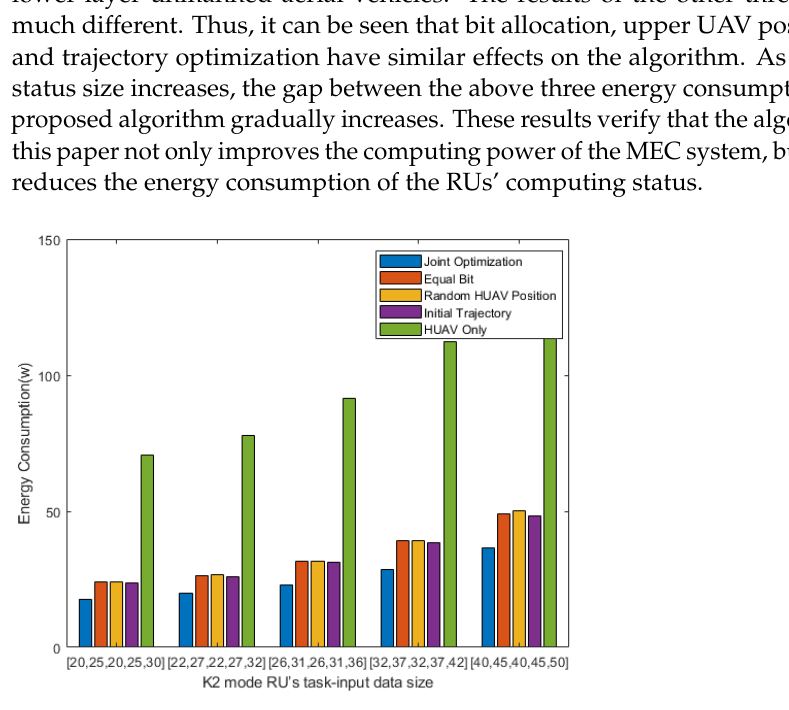
Figure 3. The relationship between the RU’s status size and each scheme’ s energy consumption in